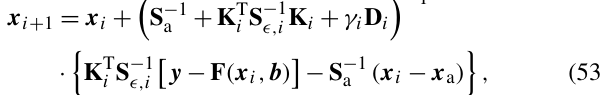
Table 3. Liquid water cloud scaling parameters and lower and upper retrieval limits.